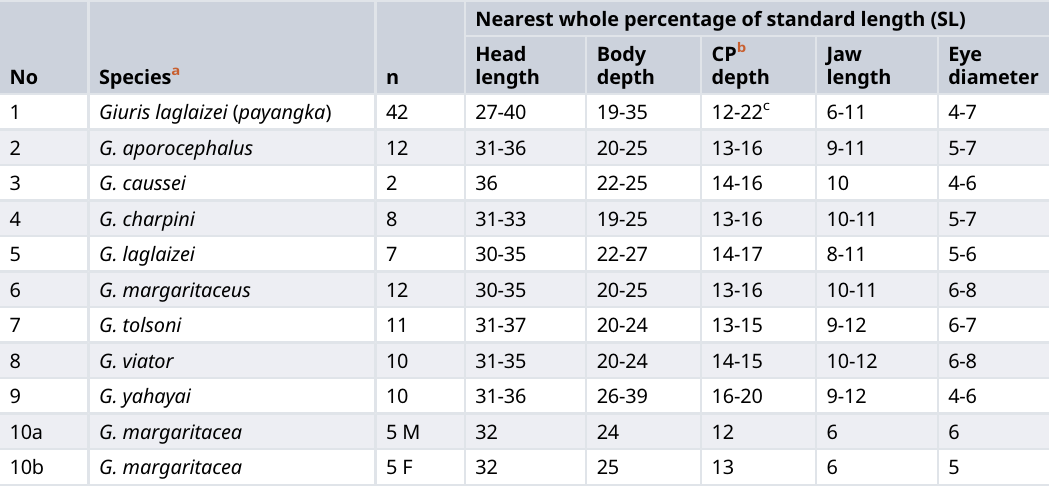
Table 8. Comparison of selected morphometric characters within the genus Giuris.